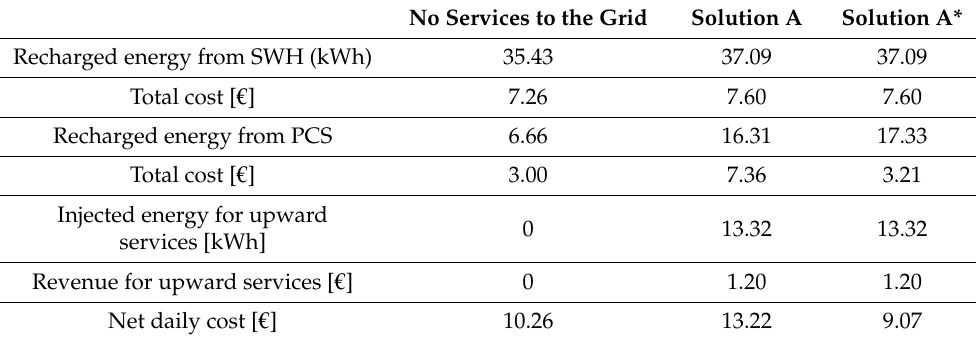
Table 21. Results of different solutions for mobility pattern 3—UVAM. No Services to the Grid Solution A Solution A* Recharged energy from SWH (kWh)